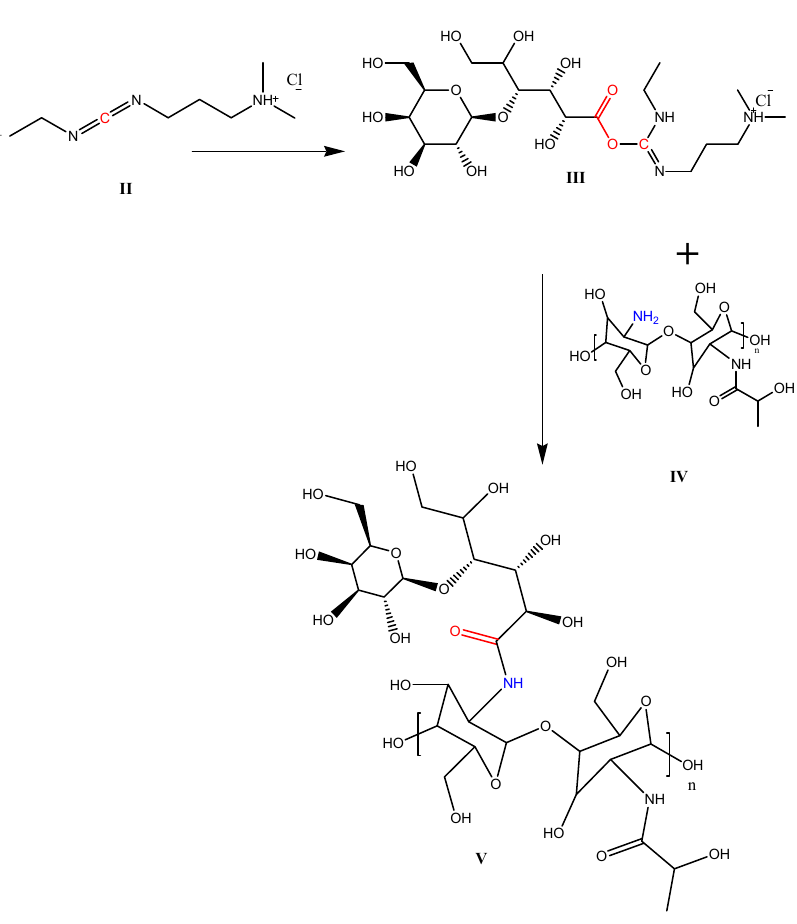
Figure 2. The proposed interaction mechanism between LA (I), EDC (II) and CL (IV) during the formation of LA-modified-CL (V).